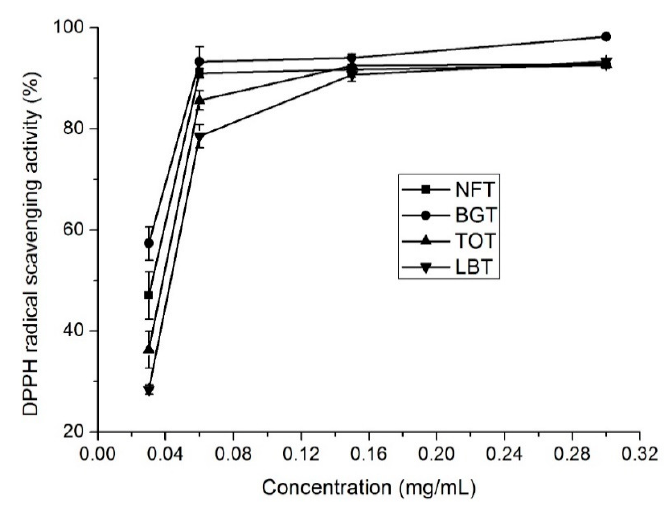
Figure 1. DPPH radical scavenging activity of different tea samples. NFT, novel fermented tea; BGT, Boseong green tea; TOT, Tieguanyin oolong tea; LBT, Lipton black tea. Table 2. EC 50 values of DPPH, hydroxyl radical scavenging activities, and reducing power. Antioxidant Activity NFT BGT TOT LBT DPPH radical scavenging activity 0.045 ± 0.01 c 0.029 ± 0.01 d 0.062 ± 0.01 b 0.077 ± 0.01 a Reducing power 0.125 ± 0.02 b 0.072 ± 0.03 a 0.127 ± 0.02 b 0.194 ± 0.08 c Hydroxyl radical scavenging activity 2.023 ± 0.17 c 1.39 ± 0.96 d 3.438 ± 3.25 b 4.524 ± 2.88 a Values are the means ± standard deviation of triplicate determinations. Means with the different letters (a, b, c, or d) in the same row are significantly different at p < 0.05. NFT, novel fermented tea; BGT, Boseong green tea; TOT, Tieguanyin oolong tea; LBT, Lipton black tea.